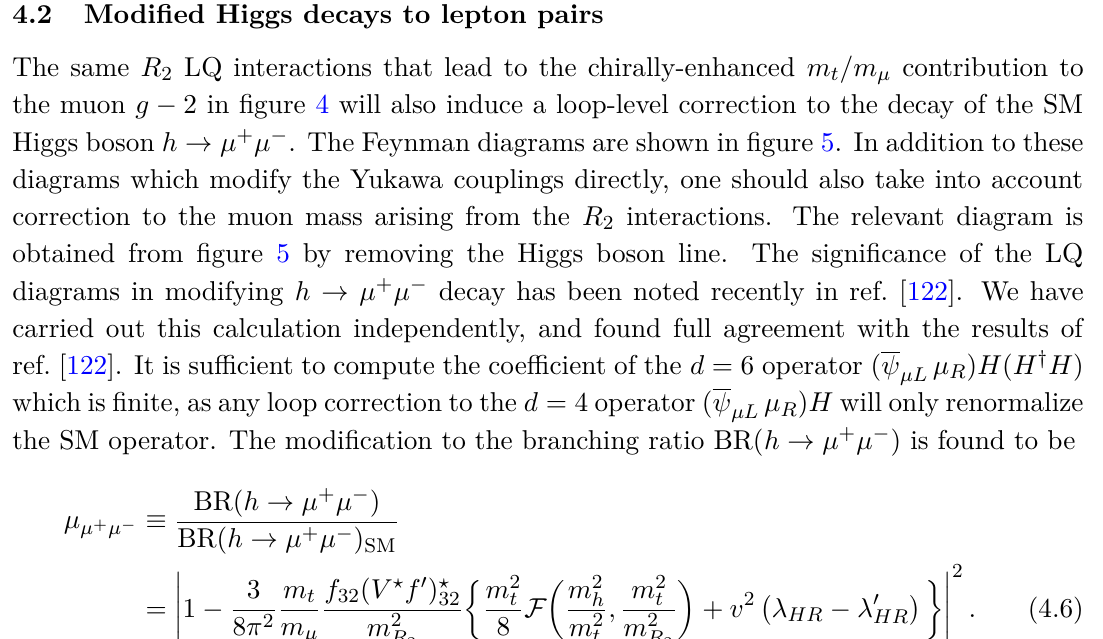
= f 0 = 0 in eq. (2.53) to avoid any αe αe